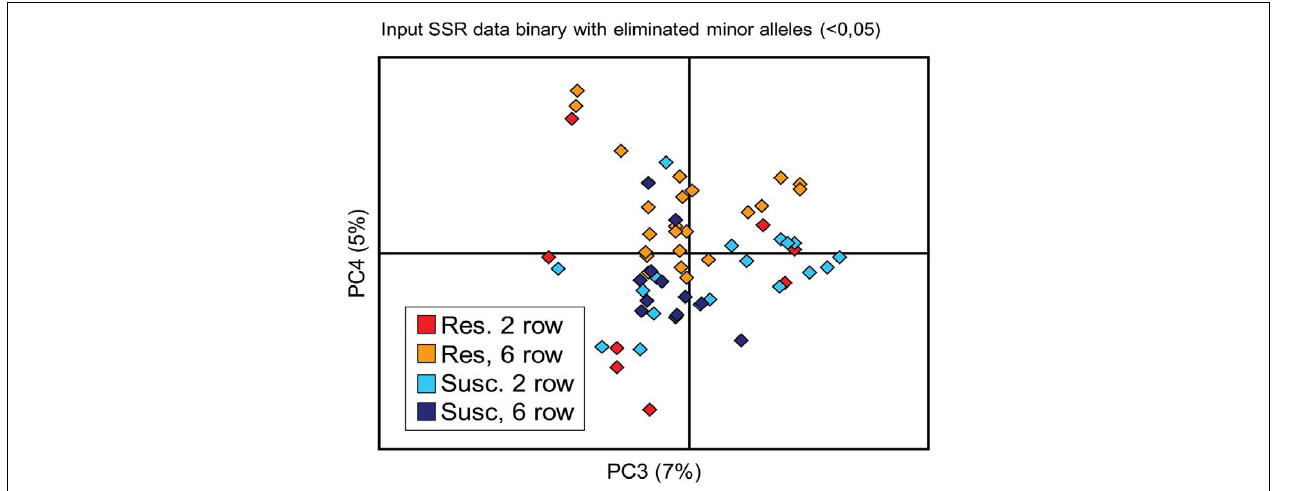
FIGUREA3 | Population structure determined by PCA of SSR data (42 SSR markers). PC3 and 4 are shown, for PC1 and 2 see Figure 3 .